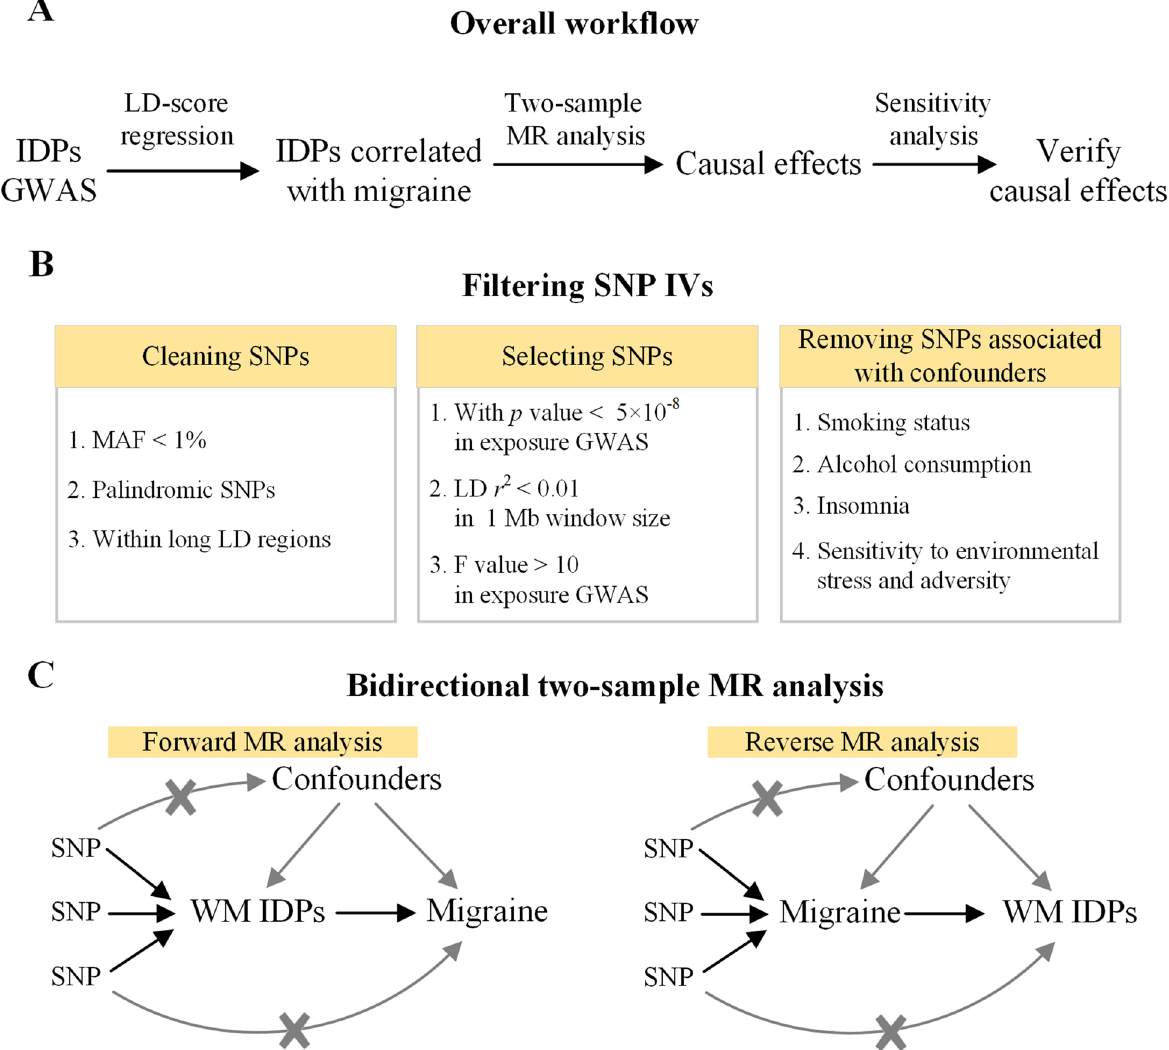
Fig. 1 Flowchart of the study. A Overall workflow of the causal inference between migraine and microstructural WM. B Filtering SNP IVs for two-sample MR analysis. C Simplified illustration of Mendelian randomization. Abbreviations: IDPs, imaging-derived phenotypes; GWAS, genome-wide association study; LD, linkage disequilibrium; MAF, minor allele frequency; MR, Mendelian randomization; SNP, single nucleotide polymorphism; WM, white